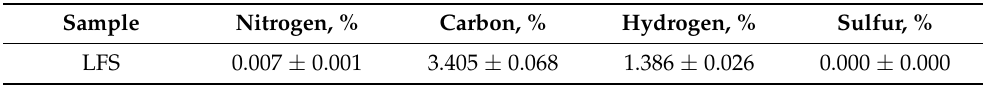
Table 4. Elemental analysis of the ladle furnace slag.